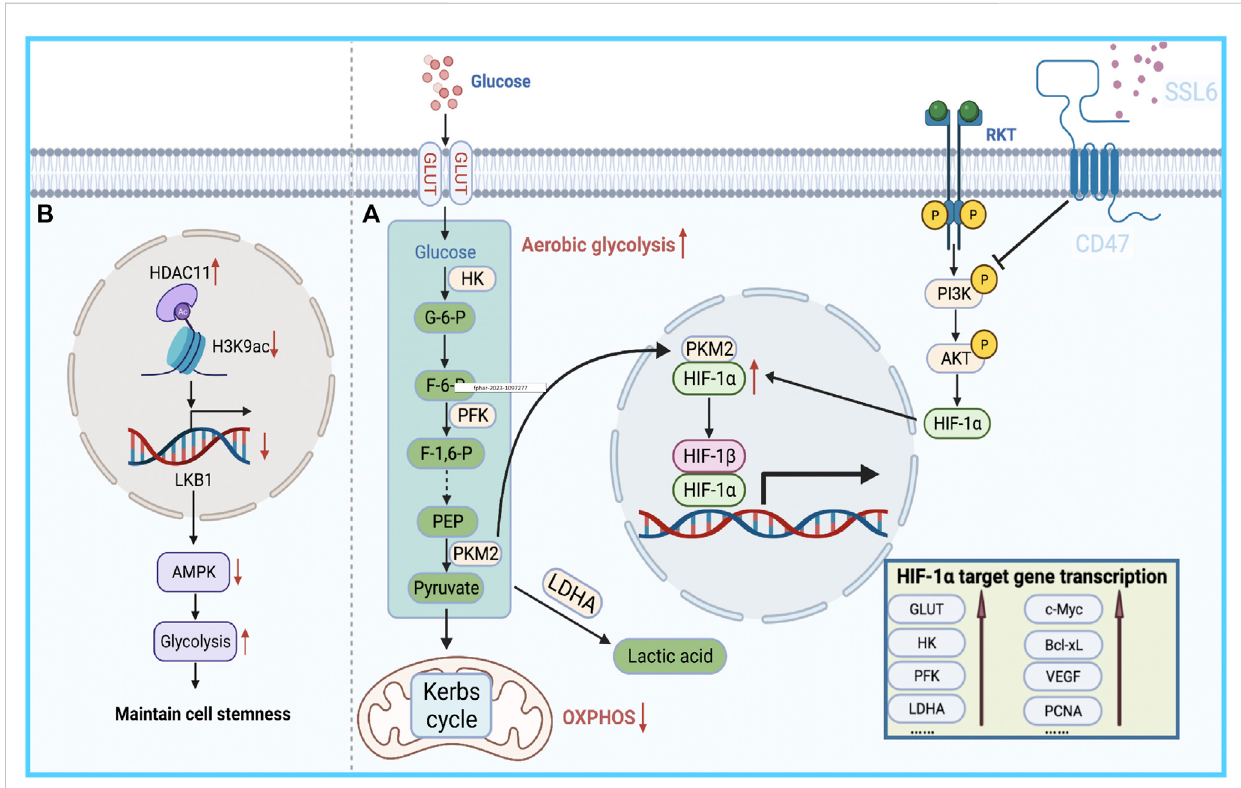
FIGURE 2 Bioenergetic propensity of HCC cells to utilize glycolysis is associated with sorafenib resistance. (A) HIFs mediate the primary transcriptional response to hypoxic stress and promote the expression of glycolysis-regulating enzymes. (B) HDAC11 inhibits the transcription of LKB1 by regulating histoneacetylation inthepromoter region ofLKB1, therebyblockingAMPK signaling andinhibitingtheglycolytic pathway,whichinturn maintains tumor cell